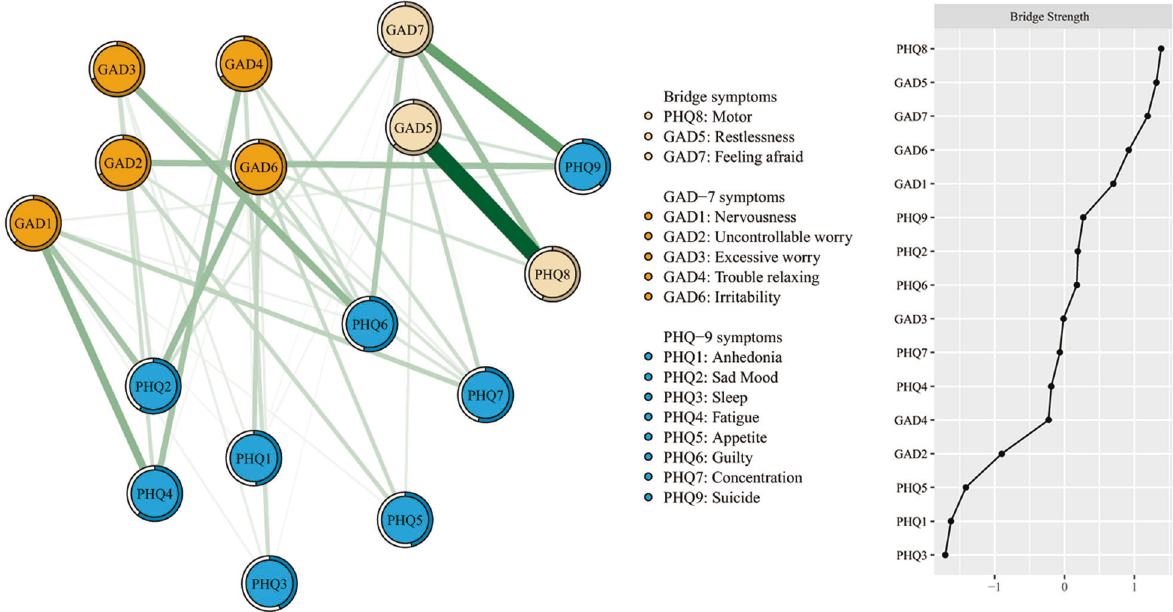
Fig. 2 Network structure of anxiety and depressive symptoms showing bridge symptoms in college students. The left panel shows the visualization of the network structure of bridging symptoms; the right panel shows the value of bridge strength in order.